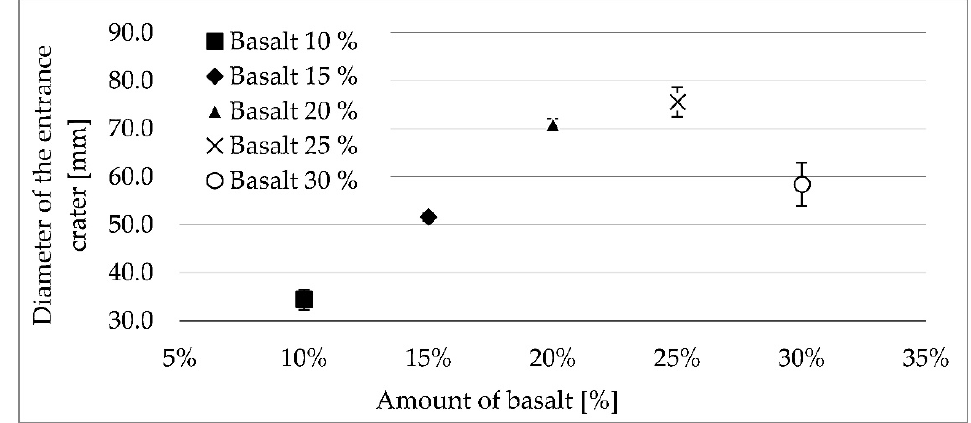
Figure 17. Diameter of the entrance crater according to the individual percentage substitutions.